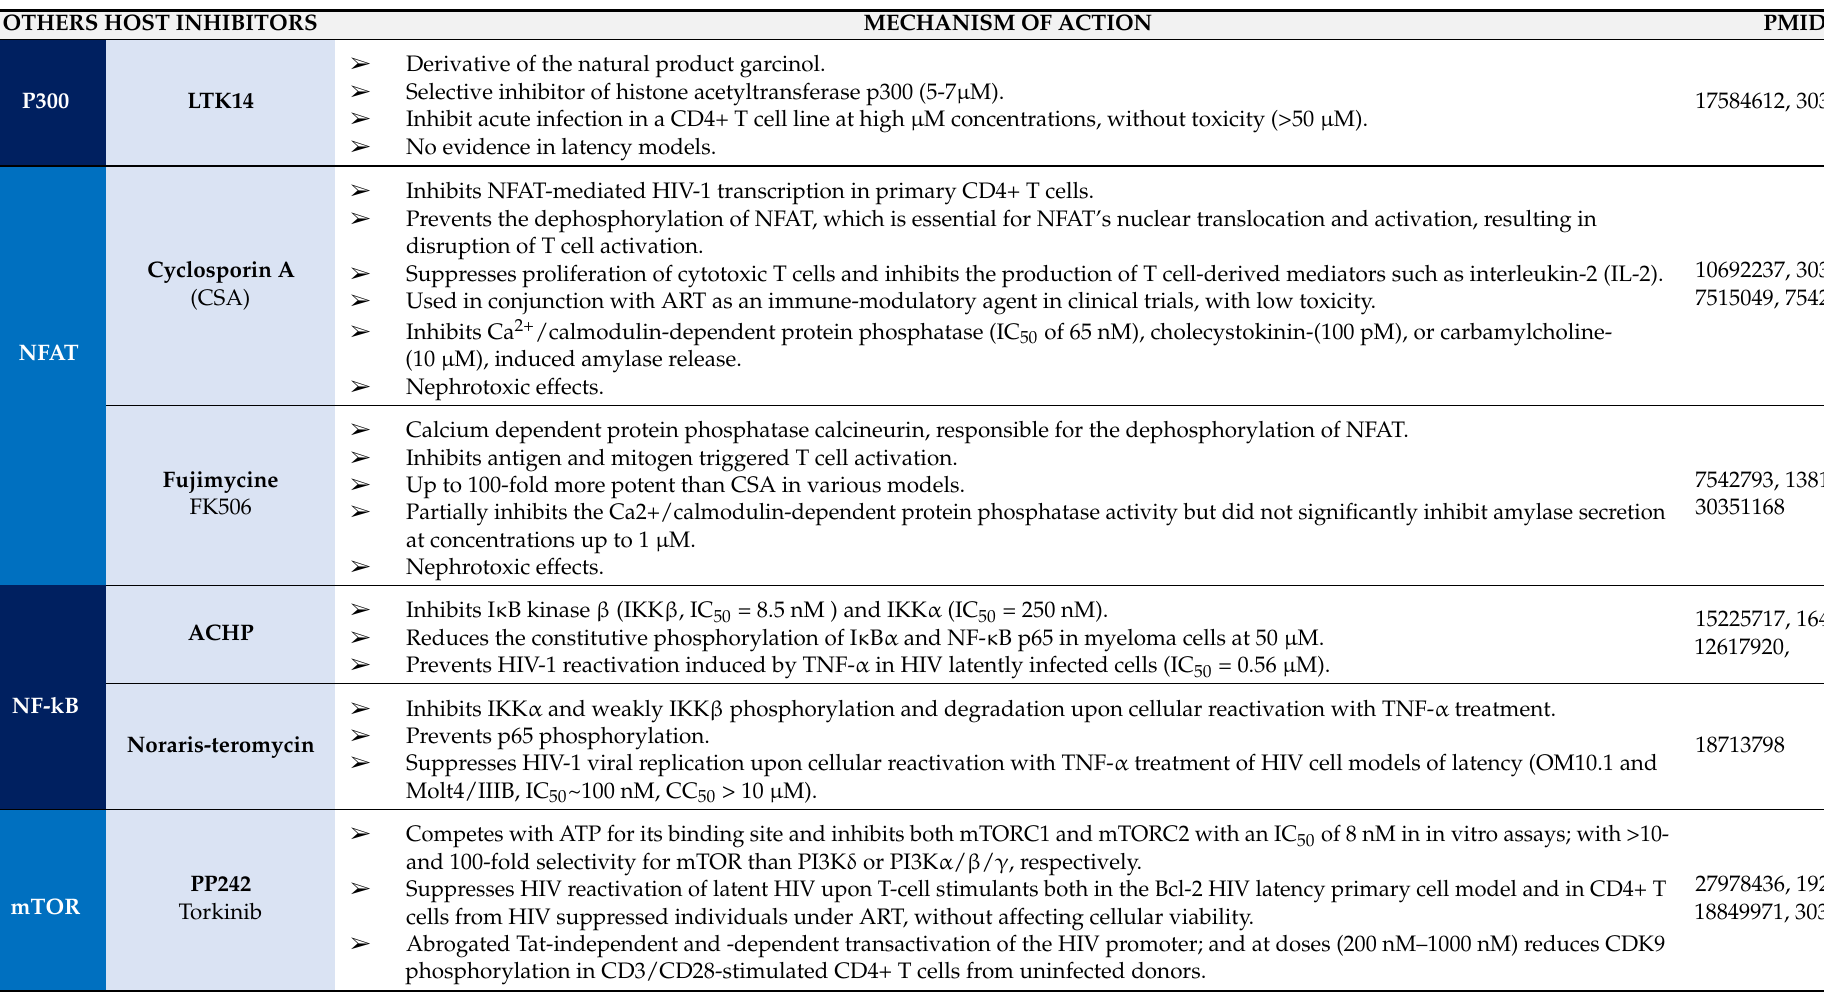
Table 2. Other host factors inhibitors (part 1) and (part